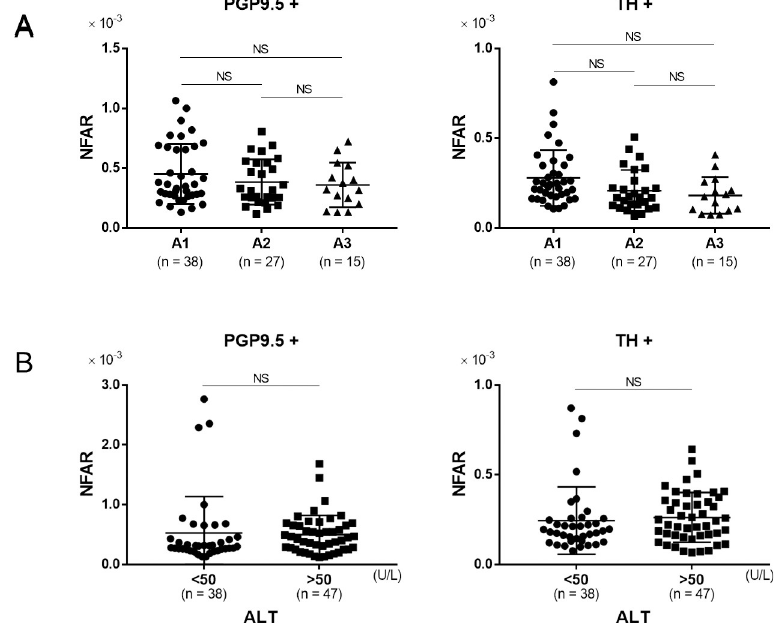
Fig 4. The relationship between inflammation and NFAR. Comparison of NFAR in for whole nerve fibers (PGP9.5 +) and sympathetic nerve fibers (TH+). A: mild inflammation (A1) to severe inflammation (A3), B: lower alanine aminotransferase (ALT) level ( < 50 U/L) vs. higher ALT level ( � 50 U/L). Data were analyzed by unpaired t test. NS: not significant.